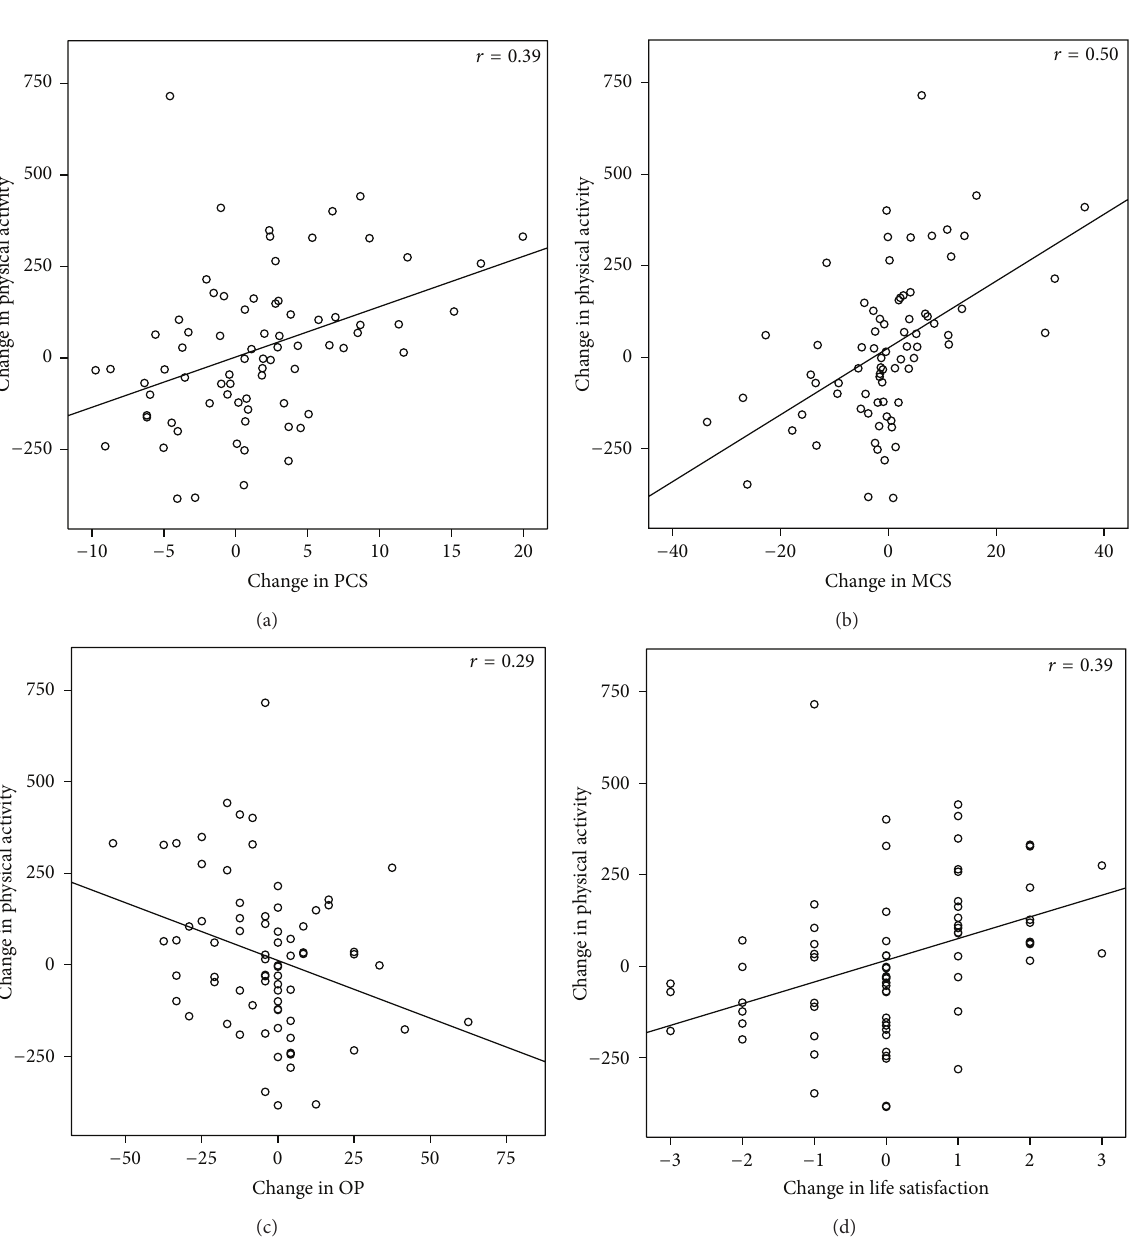
Figure 2: (a)–(d) Correlations between change in accelerometer assessing physical activity (counts per minute) and change in (a) PCS, (b) MCS, (c) OP, and (d) life satisfaction during the two-year lifestyle intervention for severely obese adults. PCS (physical component summary) score of the Medical Outcomes Study Short-Form 36 Health Survey (SF-36). Scale: 15.4–62.1. Higher scores represent better health-related quality of life. MCS (mental component summary) score of the Medical Outcomes Study Short-Form 36 Health Survey (SF-36). Scale: 10.1– 64.0. Higher scores represent better health-related quality of life. OP: Obesity-Related Problems scale. Scale: 0–100. Higher scores represent more obesity-related problems. Life satisfaction. Scale: 1–7. Higher scores represent better satisfaction with